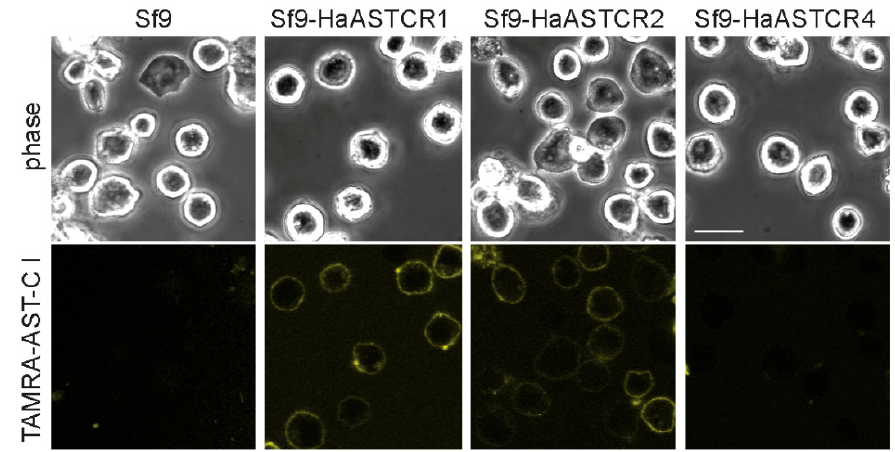
Figure 4. ASTCR localization and binding is not EGFP dependent. Live cell imaging of Sf9 insect cells alone or stably expressing H. americanus ASTCR1, 2, or 4. Cells were incubated (1 h at 4°C) with the TAMRA-AST-C I analog and imaged in the presence of 0.45 M sucrose as before using a TRITC filter (Em = 546 nm/Ex = 579 nm) with TAMRA fluorescence pseudo-colored yellow. Scale bar = 20 µm.